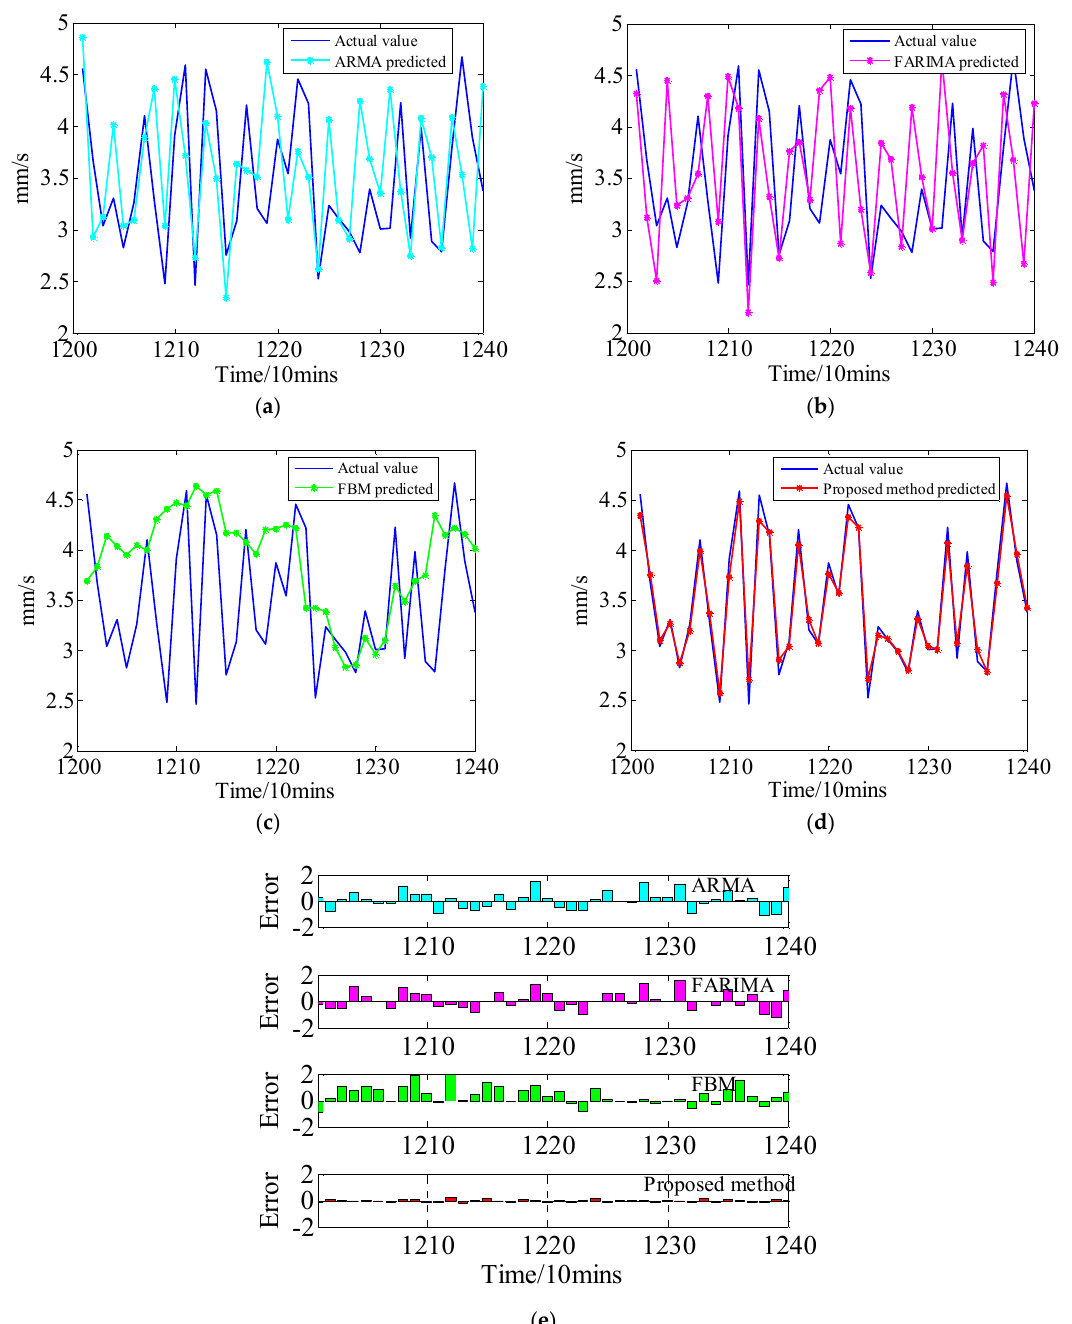
Figure 6. The EVI prediction results by the proposed method and the other state-of-the-art methods. ( a ) Prediction result using the autoregressive–moving-average (ARMA) model; ( b ) Prediction result using the fractionally autoregressive integrated moving average (f -ARIMA) model; ( c ) Prediction result using the fractional Brownian motion (FBM) model; ( d ) Prediction result using the proposed model; ( e ) Prognostic errors.